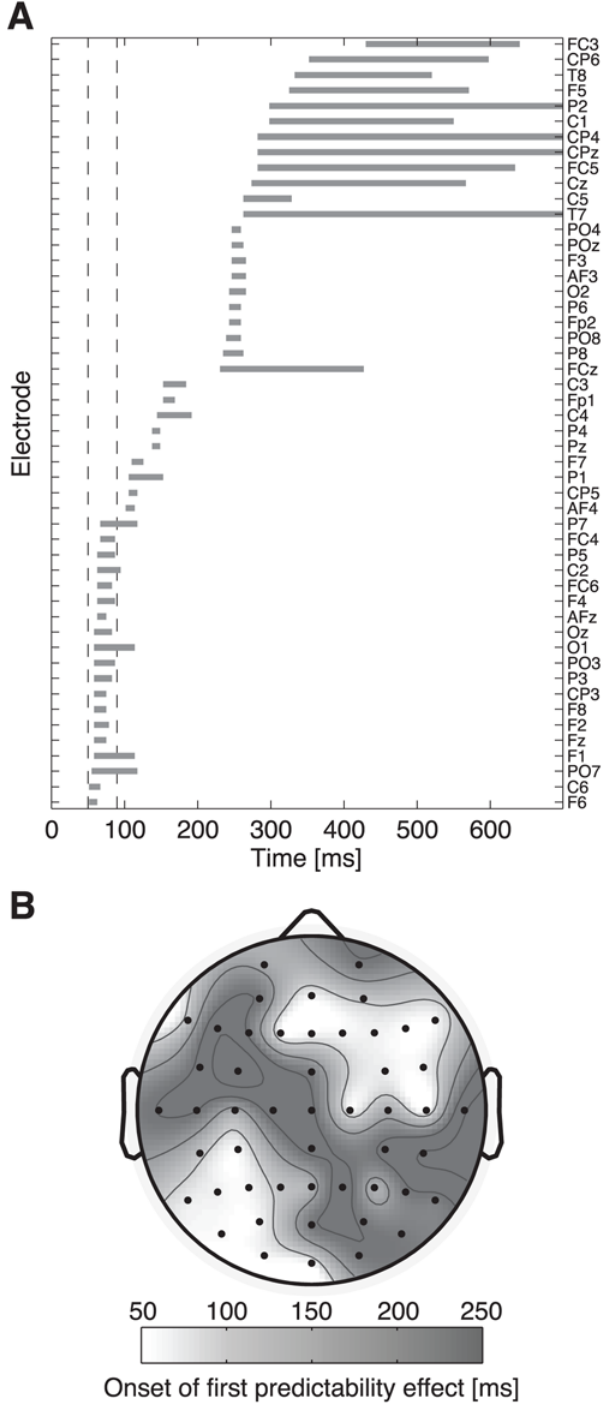
Figure 3. Latencies of the first predictability effect. (A) Gray bars illustrate onset and duration of the first significant predictability effect on 50 scalp electrodes. In the interval from 50 to 90 ms (dashed lines), the effect emerges on 19 channels. (B) The onset topography reveals early predictability effects at right anterior and left posterior sites.